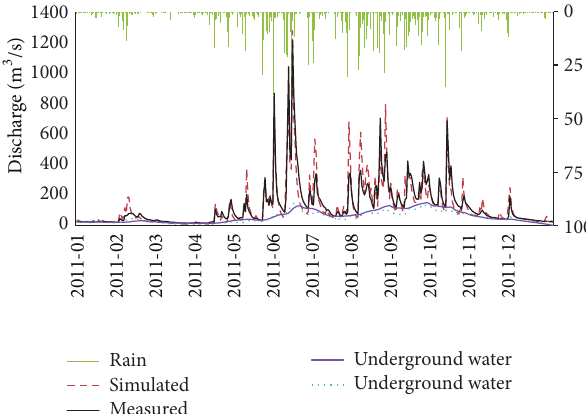
Figure 10: XAJ model validation phase (2011). Measured and simu- lated discharge, the groundwater runoff separated from the hydro- graph and calculated by Xin’anjiang model, and catchment average rainfall time series.